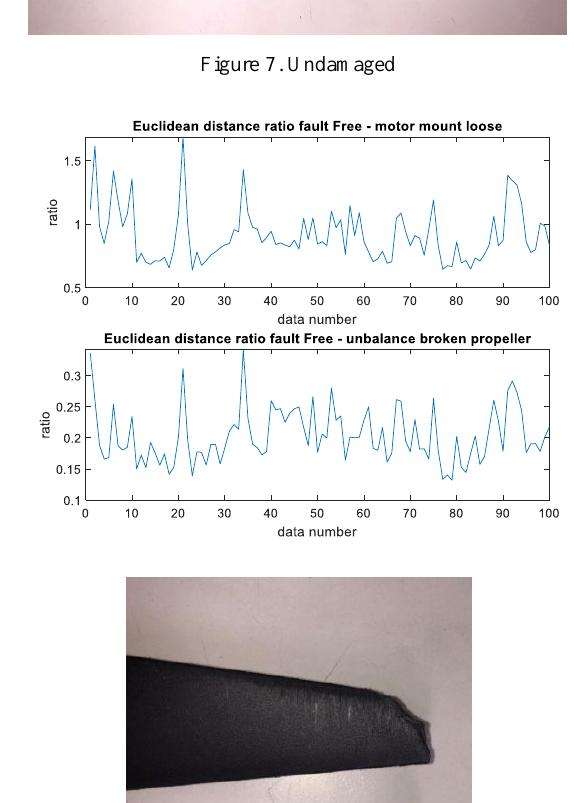
Figure 7. Undamaged